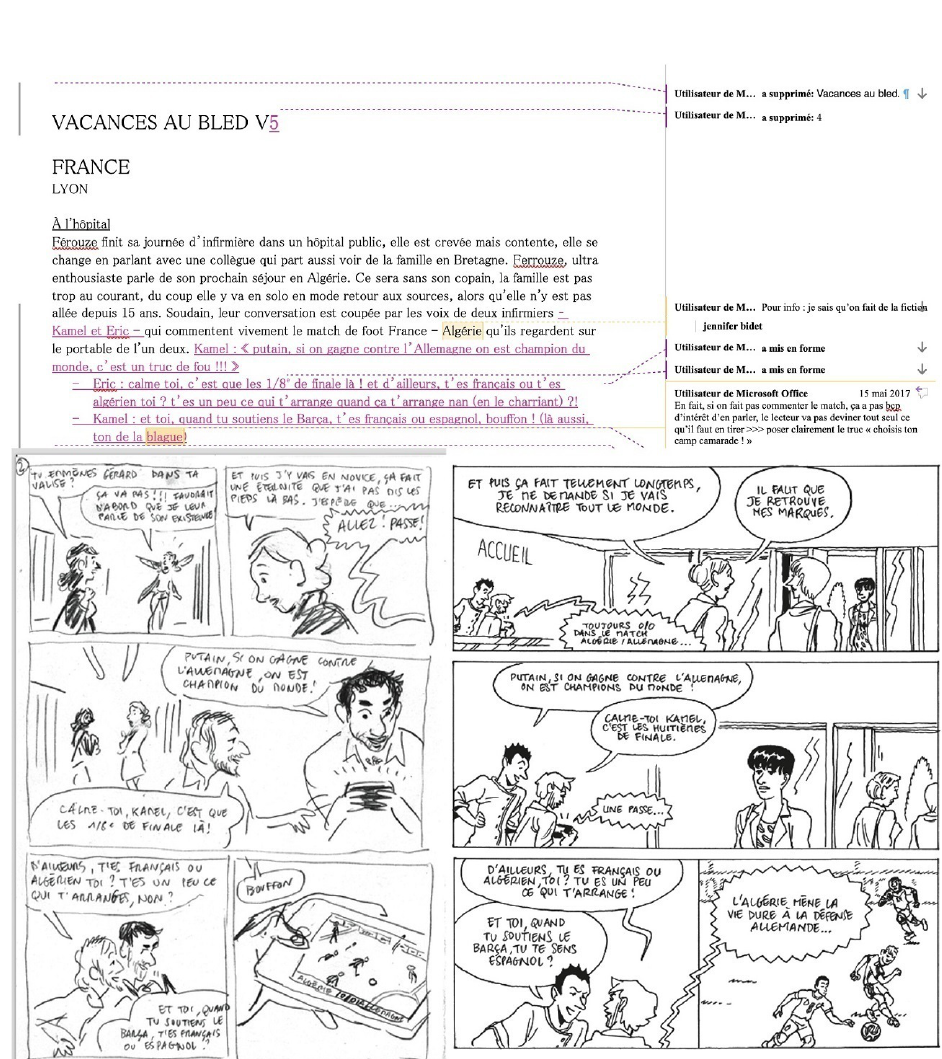
Figure 1: Vacances au bled, Bidet/Singeon